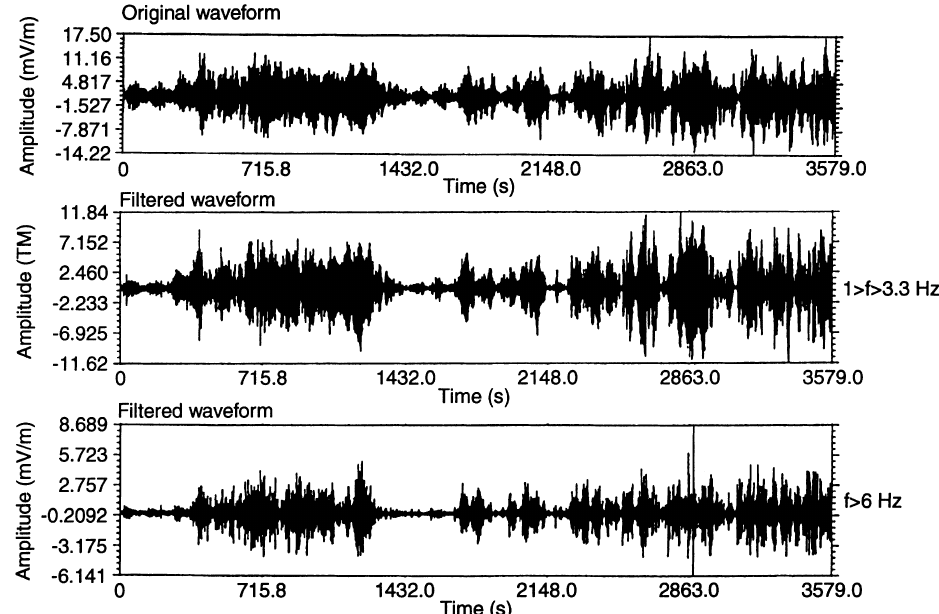
Fig. 9. Waveforms of the E component for the event displayed in X Plate 1. On the top initial signal, in the middle the signal is filtered between 1 and 3.3 Hz, in the lower part the signal is filtered above